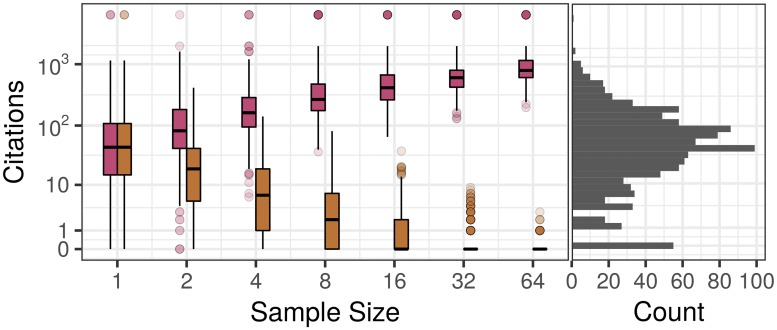
The relationship between sample size and the maximum/minimum citation count drawn in that sample.Right: histogram of citation counts for a given member of the National Academy of Sciences across their more than 1000 publications. Left: boxplots for the maximum (red, top) and minimum (orange, bottom) citation count drawn in samples of the size indicated by the horizontal axis. Each sample of a given size was repeated 1000 times to generate the distributions indicated by the boxplots.